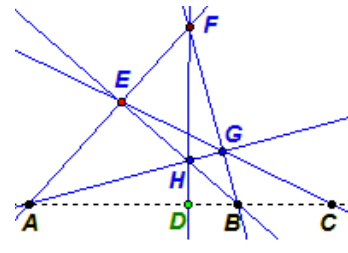
Figure 2. Four Harmonic points.